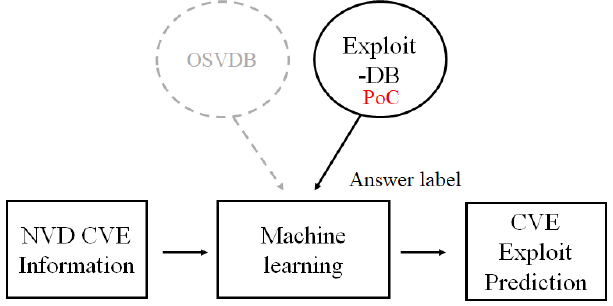
Figure 1. CVE exploit prediction using supervised machine